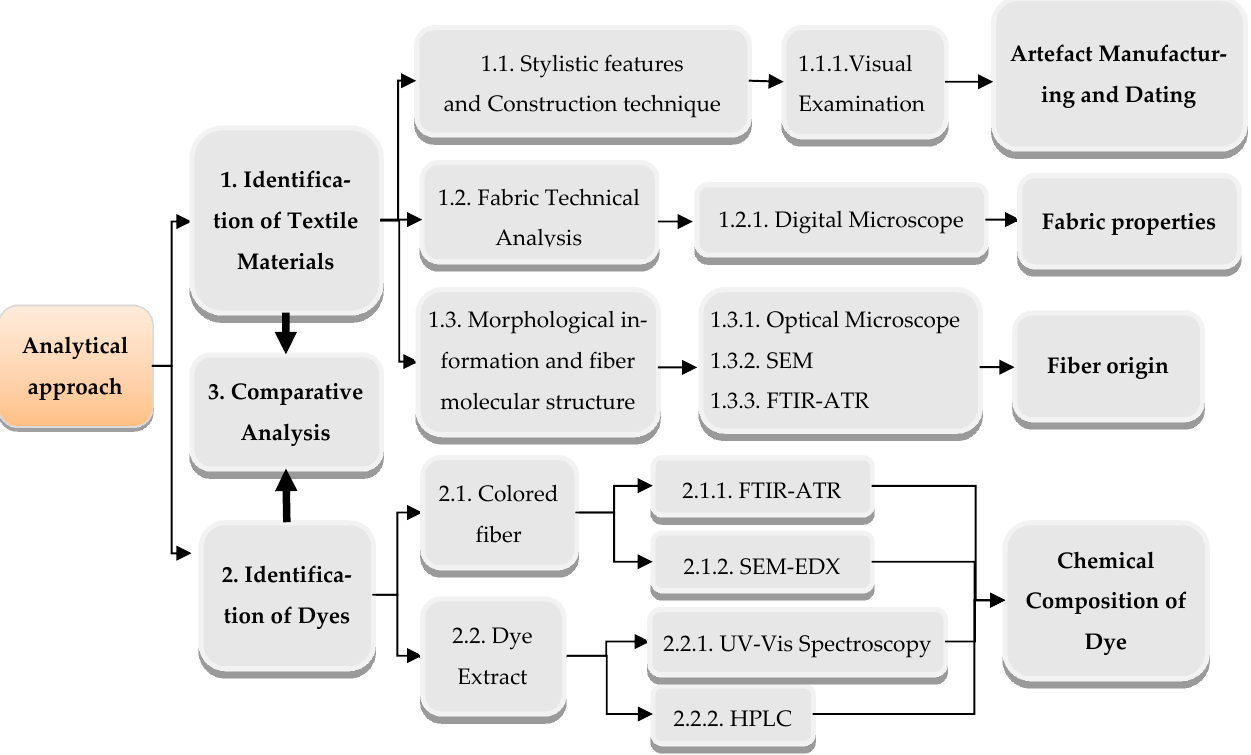
Figure 2. Analytical Methodology Applied.